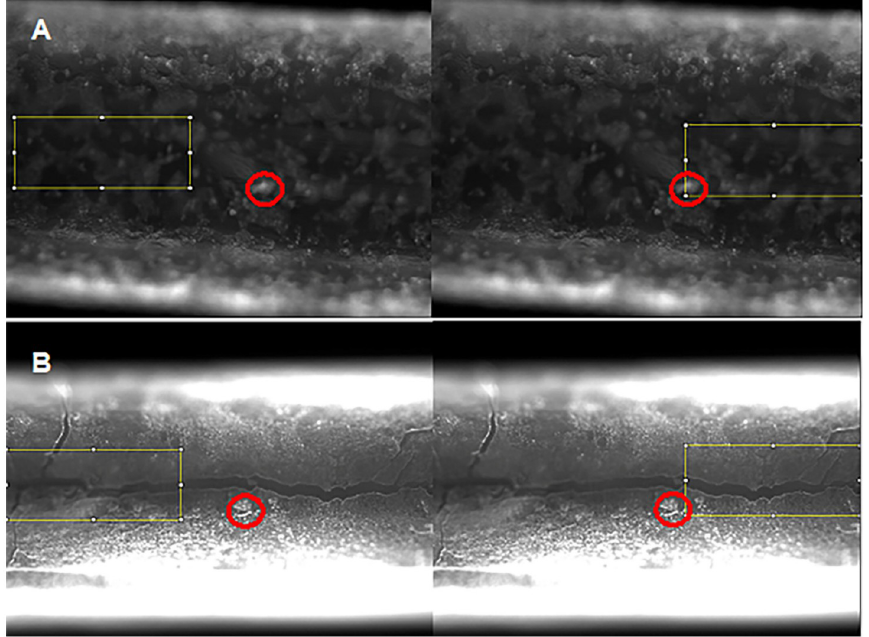
Fig 1. Representative balloon coating images illustrating methods used for assessing uniformity. Red circles indicate points of reference for recording the location of segments examined (yellow boxes). Each picture has a width of 1973 μ m and a height of 1457 μ m, and the illustration highlights two distinct areas (left-right) for histogram-based fluorescence analysis. In A (top row), balloon 1 coated with 5 layers (5LYR1), the red circle is 5941 μ m from proximal end, and in B (bottom row), balloon 2 coated with 15 layers (15LYR2), the red circle is 5504 μ m from the proximal